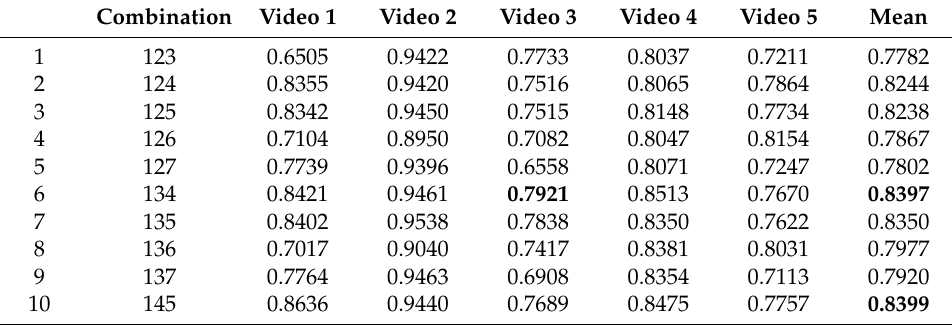
Table 1. Average F-Measures on the five videos (3-band case).